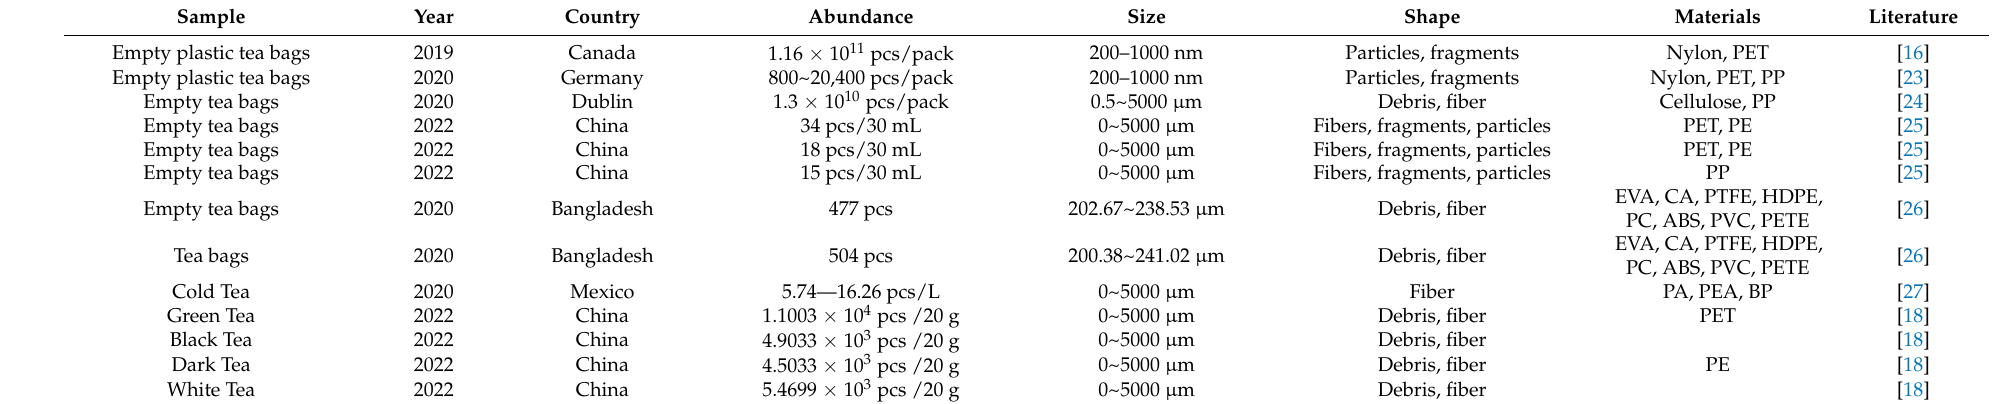
Table 1. Tea microplastic contamination distribution